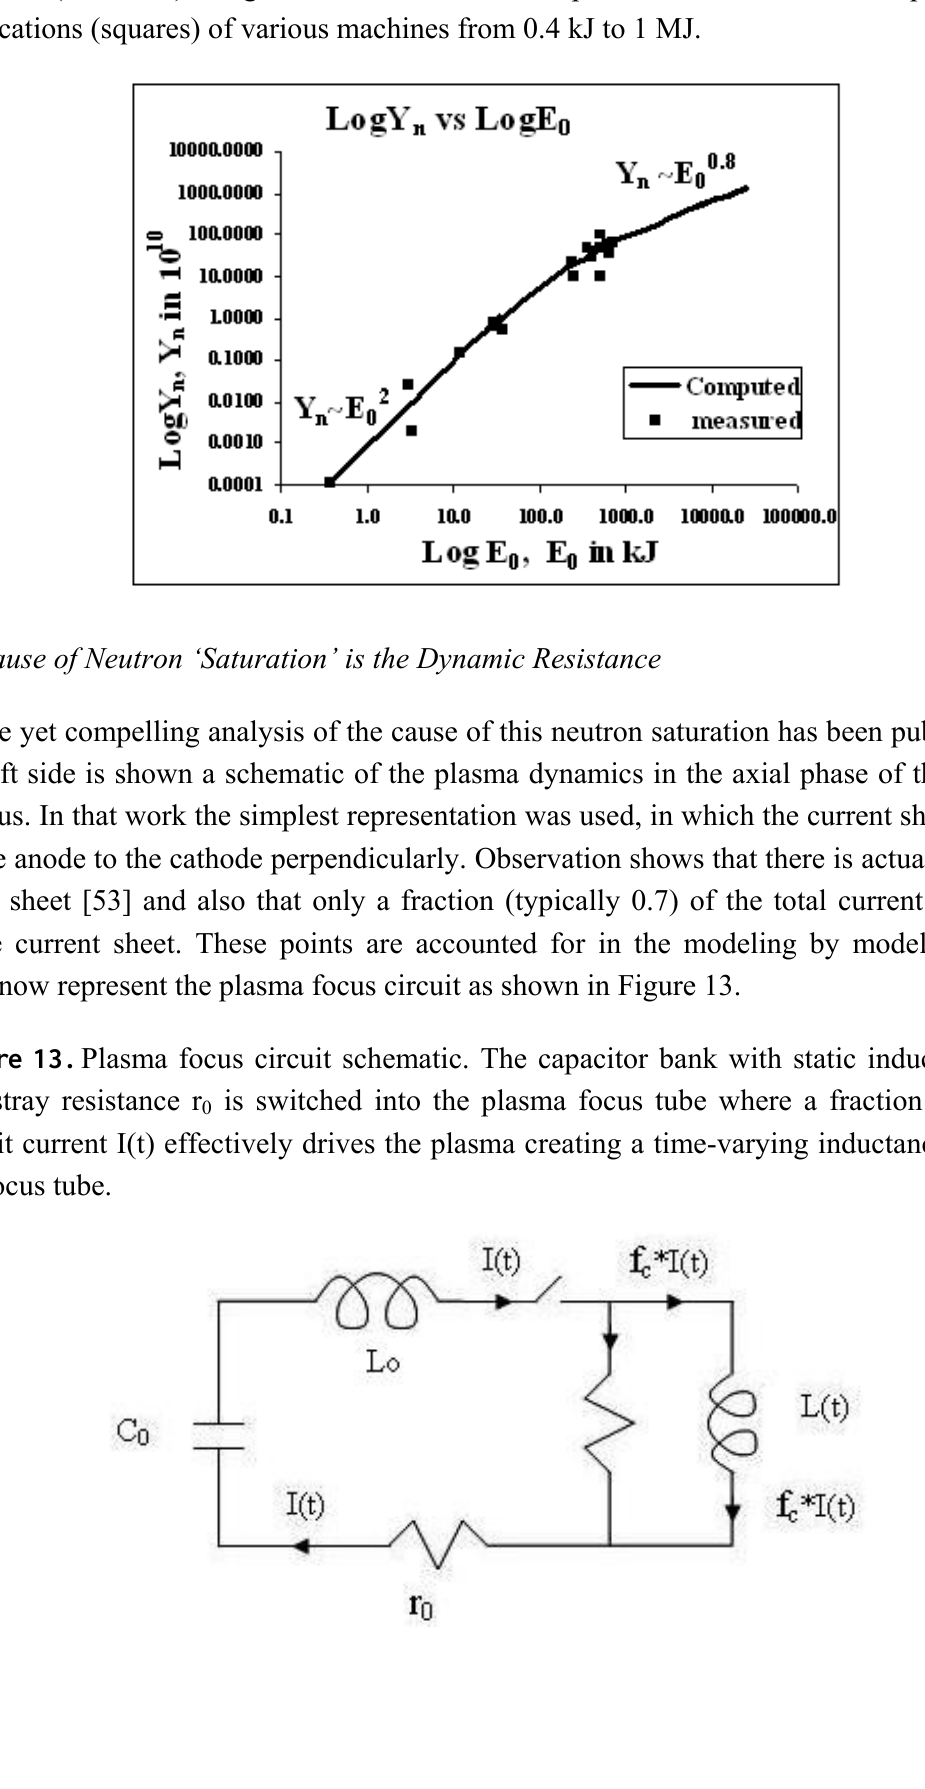
Figure 12. The global scaling law, combining experimental and numerical data. The global scaling deterioration observed in numerical experiments from 0.4 kJ data illustrates Y n to 25 MJ (solid line) using the Lee model code, compared to measurements compiled from publications (squares) of various machines from 0.4 kJ to 1 MJ.